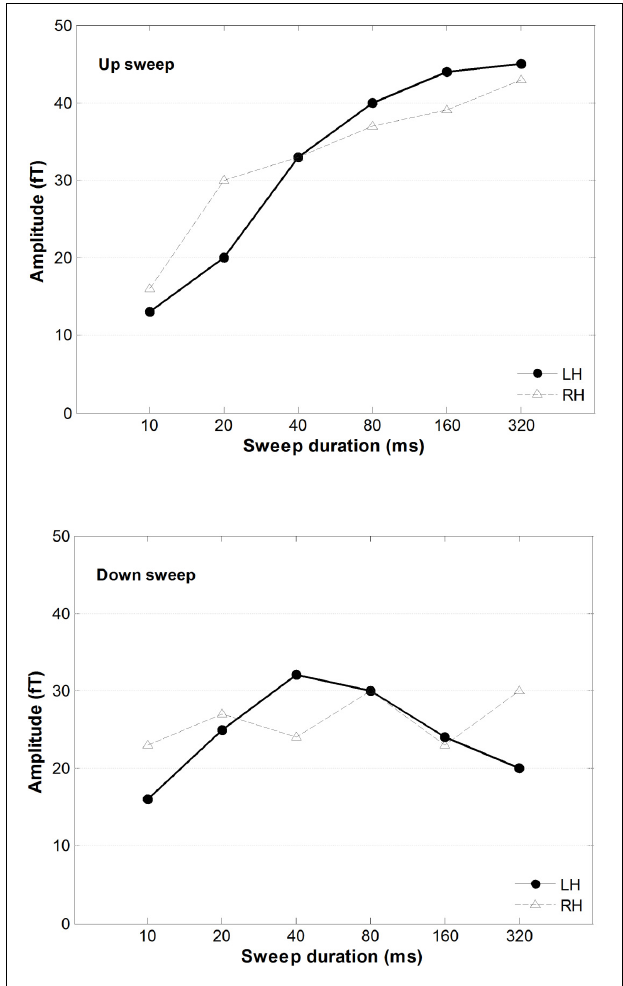
FIGURE 6 | The averaged MMNm peak amplitudes for upward (top) and downward (bottom) FM sweeps as a function of sweep duration. Solid and dashed lines indicate response amplitude in the right and left hemisphere,